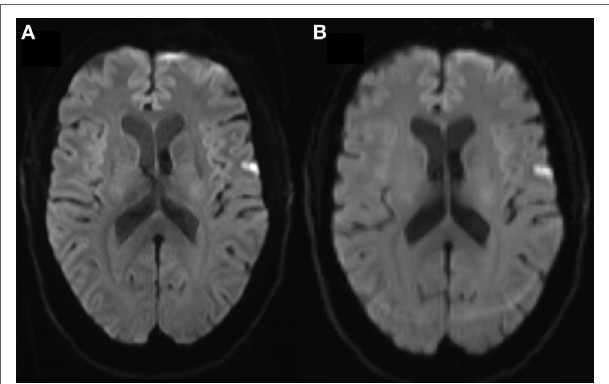
FiGURe 2 | (A) Three and (B) 20-gradient direction diffusion-weighted imaging (DWI) images of 68 years female with 2 h lasting transient ischemic attack symptoms including right hand paresis and slurred speech. In (B) , note the occipital ring artifact, blurred contours of the right-sided cortical diffusion lesion and blurred cortex outline due to motion. Three-gradient direction DWI had acquisition time 2 min and 7 s and 20-gradient direction DWI had 4 min and 39 s, both were standard vendor